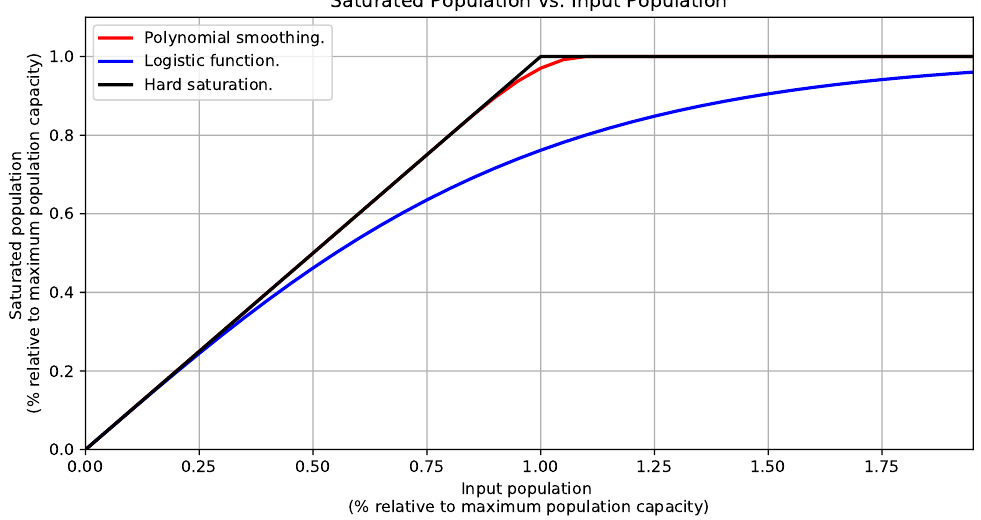
Figure 11. Tested functions for saturating the predicted population given a maximum population